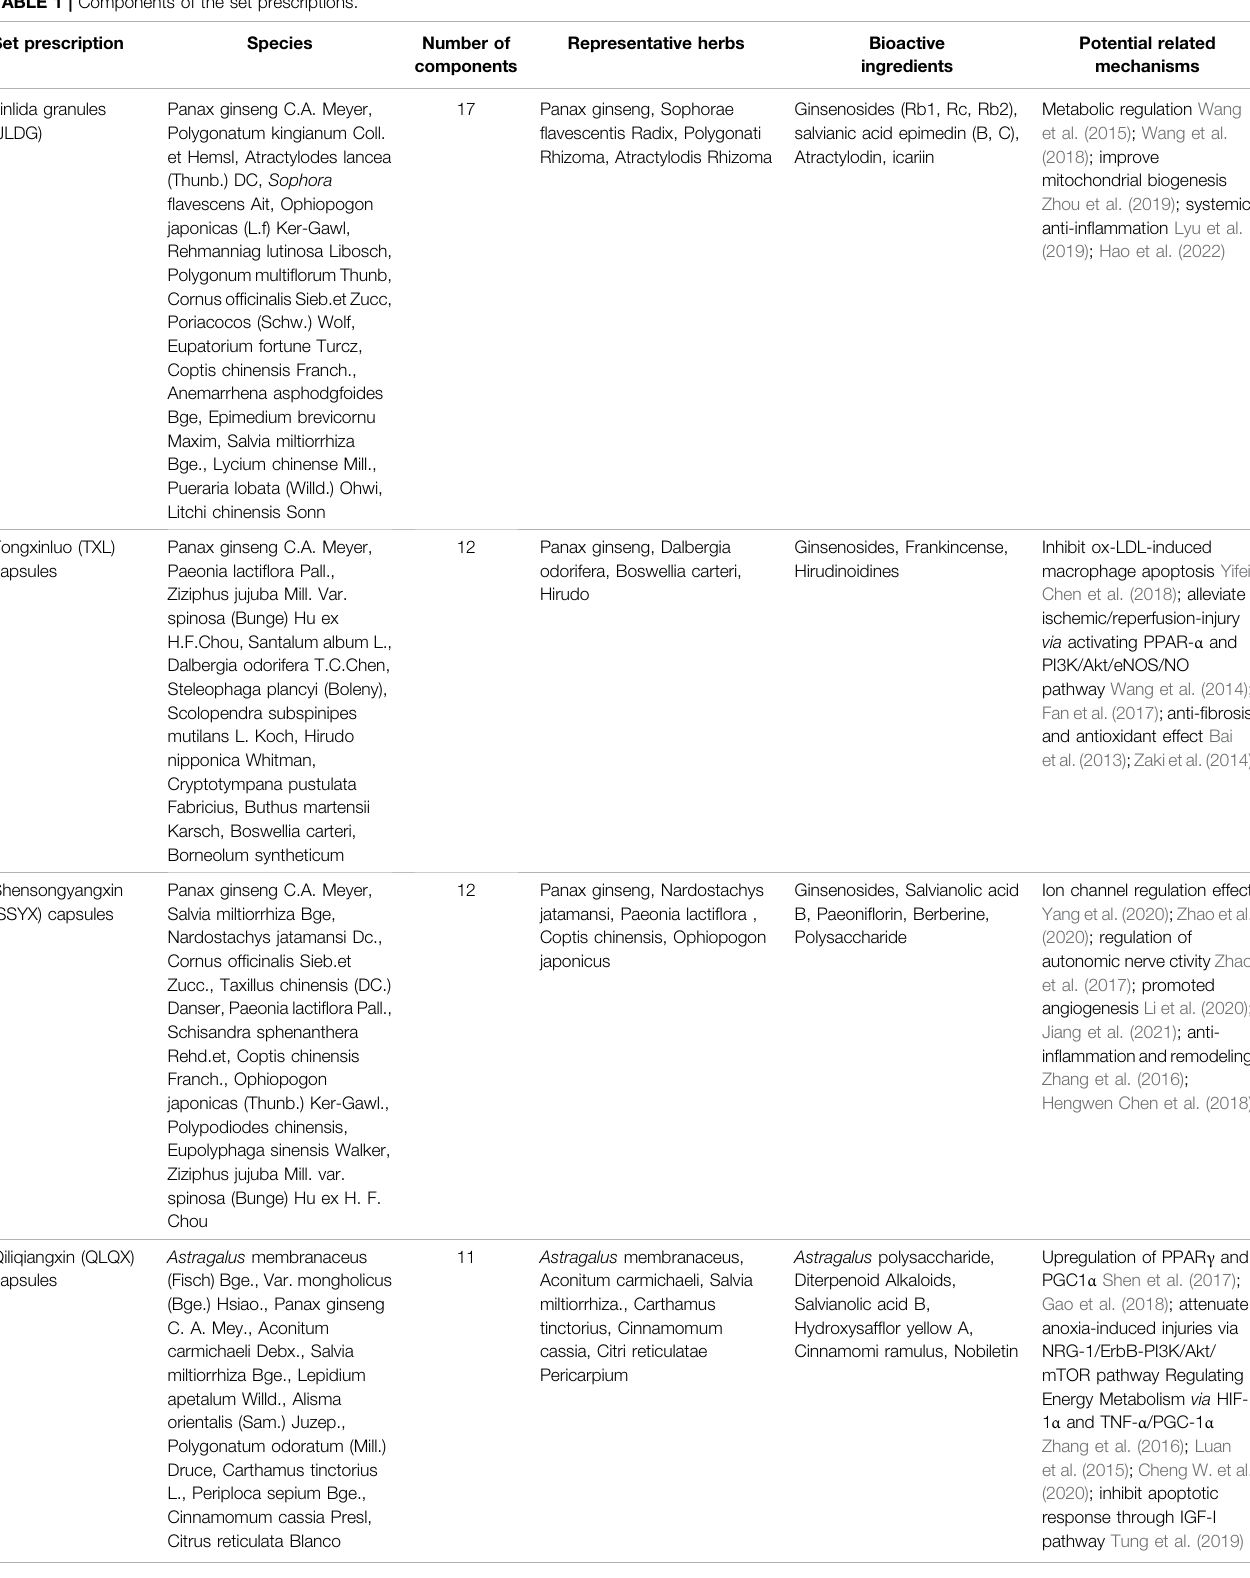
TABLE 1 | Components of the set prescriptions. Set prescription Species Number of